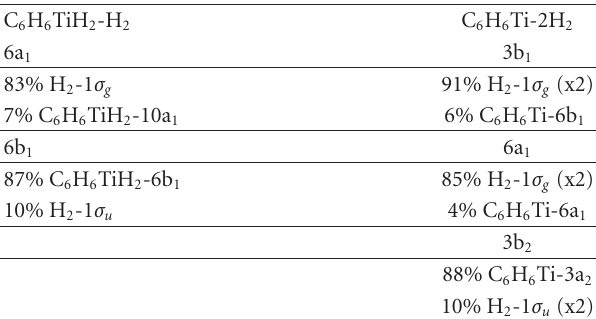
Table 3: Compositions of the MOs involved in the H 2 dona- tion/backdonation bonding mechanism for the adsorption of two H 2 molecules on the C 6 H 6 Ti